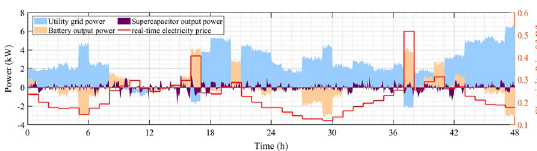
Fig. 5 Second-stage economic dispatch considering the PV and WT uncertainties (10% forecast error)